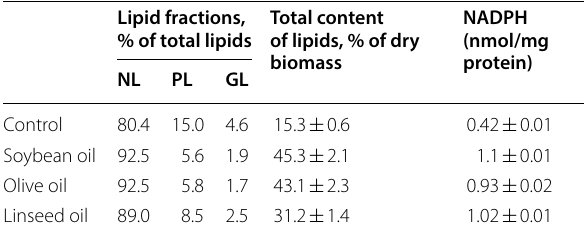
of plant oils the